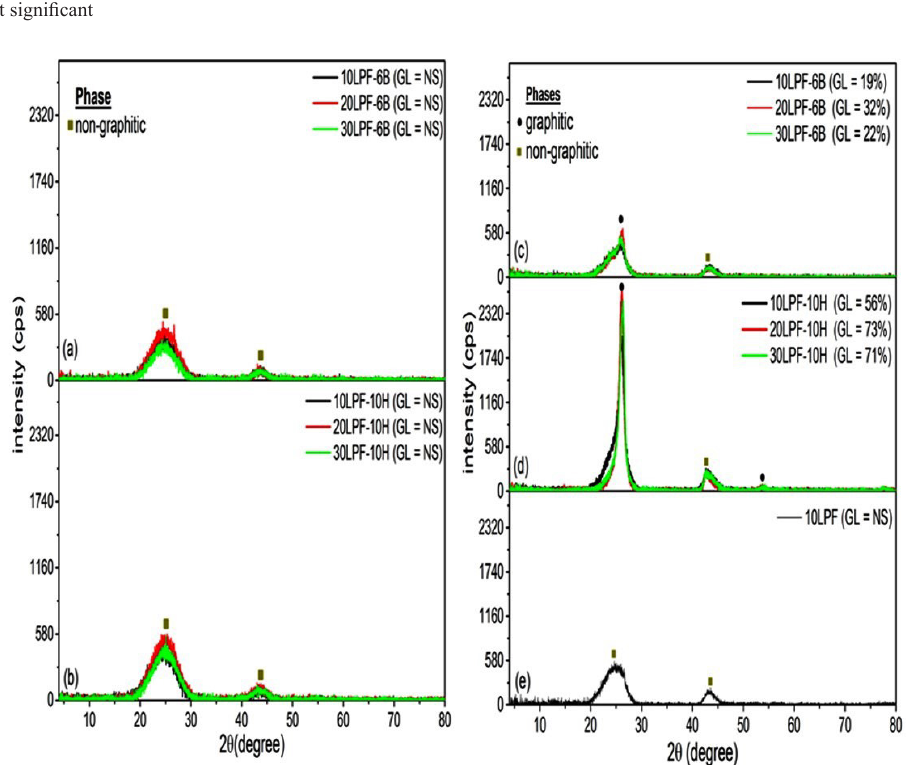
Figure 5. XRD profiles of carbons derived from lignin-phenol-formaldehyde resins containing boron compounds after pyrolysis at: (a-b) 1000 °C and (c-e) 1500 °C for 5hours. LPF = lignin-phenol-formaldehyde resin, 6B = 6 wt.% boron oxide, 10H = 10 wt.% boric acid, NS = not significant.